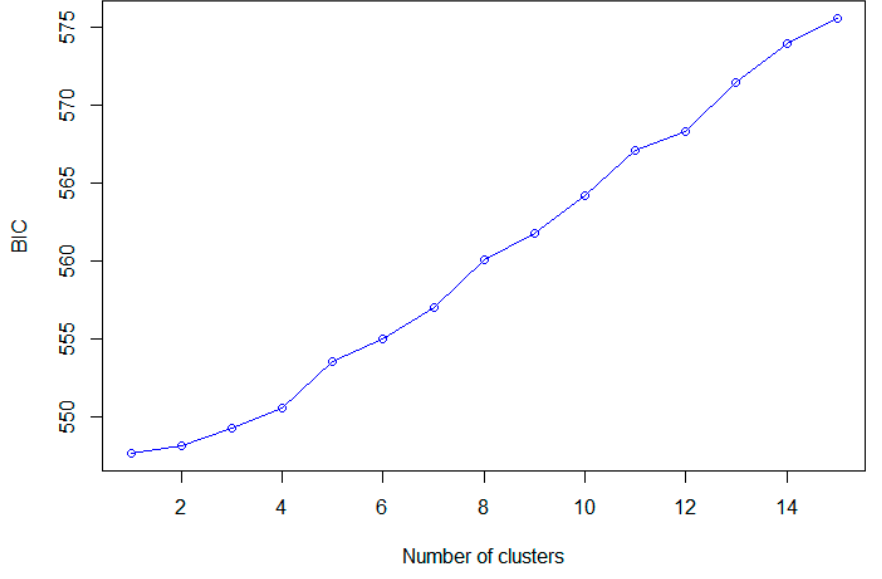
Figure 3. Bayesian inference criterion (BIC) values versus numbers of clusters (K), ranging from 1 to 15. Results suggest that K = 1 was the most likely number of genetically distinct clusters.